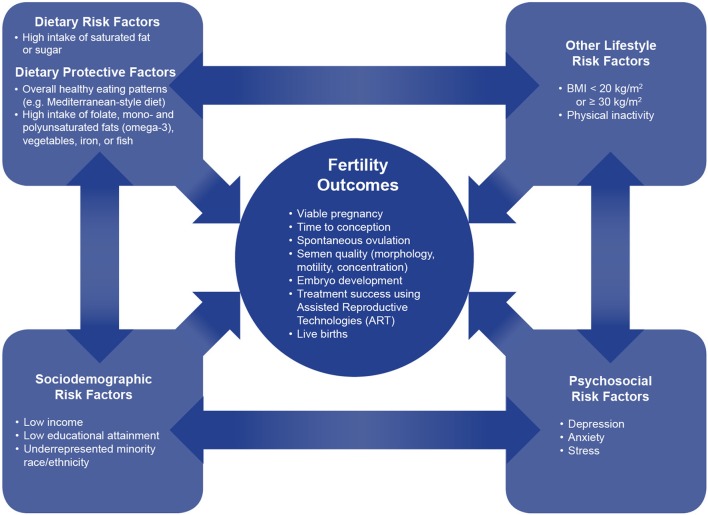
The interconnection between dietary, lifestyle, sociodemographic, and psychosocial factors on fertility outcomes. This conceptual framework shows the interconnections between dietary, lifestyle, sociodemographic, and psychosocial factors on fertility outcomes. Dietary factors, both protective and harmful, have bidirectional relationships with sociodemographic, psychosocial, and lifestyle risk factors. Dietary factors independently, as well as together with these correlated factors, impact multiple fertility outcomes.